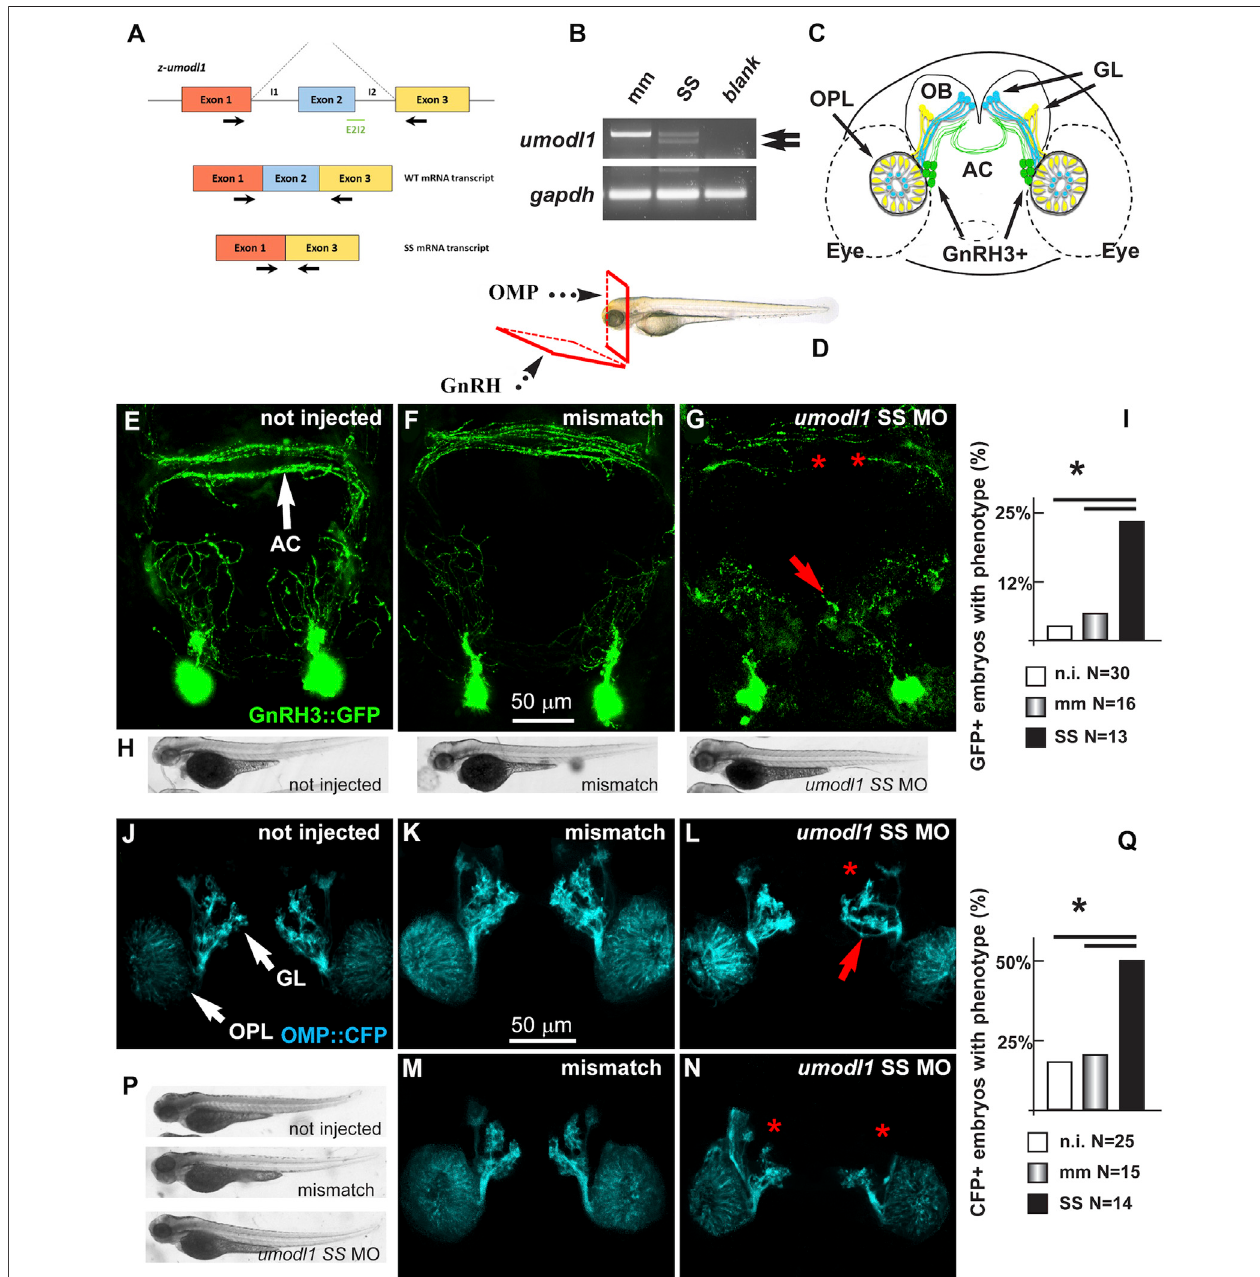
FIGURE8| Depletionof z-umodl1 affectsfasciculation,trajectory,andconnectivityofGnRH3+andOMP+neuronsofthezebra fi sholfactorysystem. (A) .Scheme ofexon/intronjunctionsofthe z-umodl1 gene.Thenormalsplicingisshownonthetop,theabnormalsplicingduetotheSplice-Site(SS)MOisonthebottom.Thisaltered splicing leads to a frame-shift mutation. Black arrows indicate the primers used for the mRNA analysis to detect the aberrant splicing. (B) . RT-PCR analysis of RNA from mismatch and SS MO-injected embryos, ampli fi ed with the primers indicated in panel a. In the sample from SS MO-treated embryos an additional band lacking exon2isevidentthatisnotpresent inthecontrolsample.The z-gapdh mRNAwasalsodetected forreference. (C) .SchemeshowingthepositionsoftheGnRH3:GFP+ neurons(in green),the OMP: CFP +neurons (in blue) and theTrcp2: Venus +neurons(in yellow,not used inthis study) relative totheeyes,the olfactoryplacodes (OPL), the olfactory bulbs(OB) andthe olfactory nerves, inafrontalview. Theanterior commissure (AC) isshown at thebasisoftheOB. (D) .Scheme illustrating theview planes for the images of the GnRH + neurons (anterior-ventral) and for the OMP + neurons (frontal). GL, Glomeruli. (E – G) . Micrographs of gnrh3:GFP zebra fi sh embryos that were either not injected (D) or injected with the control mismatched MO (E) or with anti- z-umodl1 SS (F) MO. In control injected embryos, no signi fi cant alteration was observed compared to not injected. White arrows indicate the normal position of the GFP + neurons. Red arrows and asterisks indicate, respectively, misrouted GFP + fi bers and altered fasciculation or absent fi bers. (H) . Whole-mount bright fi eld micrographs of embryos corresponding to the micrographs above, showing normal embryonicmorphologyandgrowth. (I) .Quanti fi cationoftheobservedphenotype(alteredfasciculation/trajectory),expressedasapercentoftheinjectedGFP+embryos